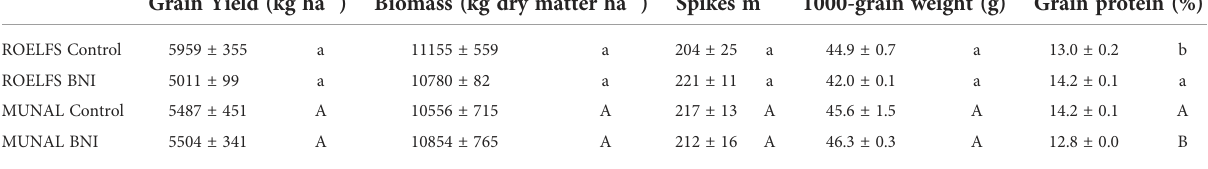
TABLE 1 Grain yield, dry matter biomass, number of spikes, 1000-grain weight and grain protein of ROELFS and MUNAL BNI-isogenic-lines fertilized with 250 kg N ha -1 as ammonium sulphate. Grain Yield (kg ha -1